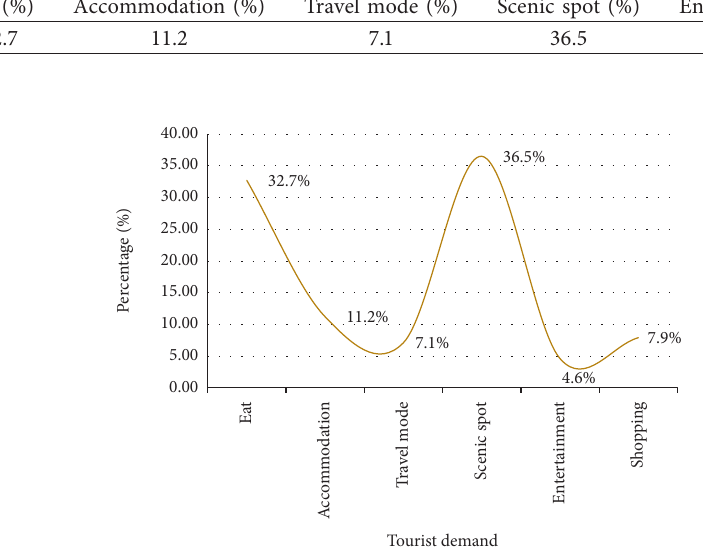
Figure 4: Tourists’ demand for tourism Table 7: Frequent set mining results under different tourism data sets.